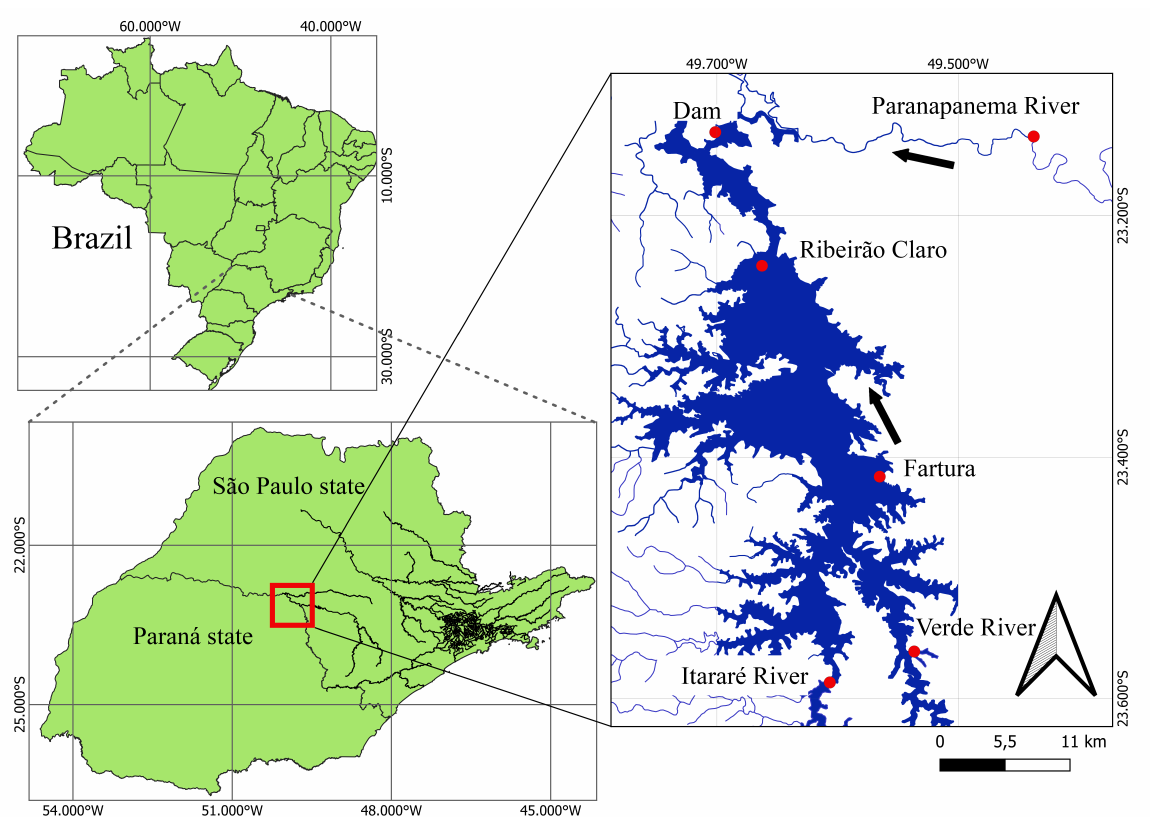
Figure 1. Map of the state of São Paulo, indicating the location of the Chavantes Reservoir, middle Paranapanema river basin, in the lentic stretch: Dam, Ribeirão Claro and Fartura, and lotic: Parapanema River, Itararé and Verde River. Black arrow = river